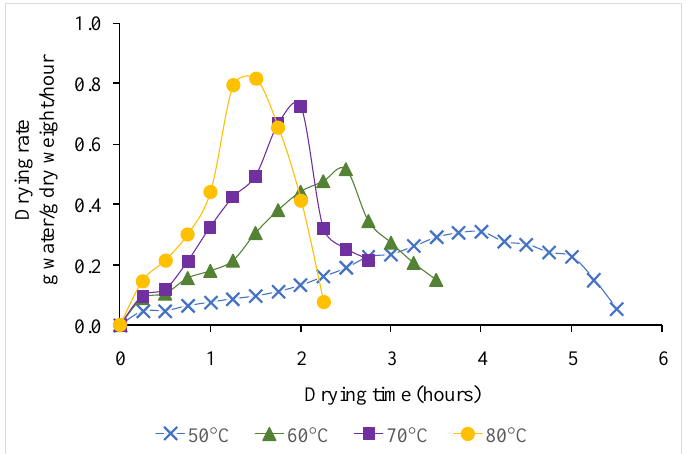
Figure 5. Drying rate of foamed magenta leaves extract versus drying time at different temperatures.